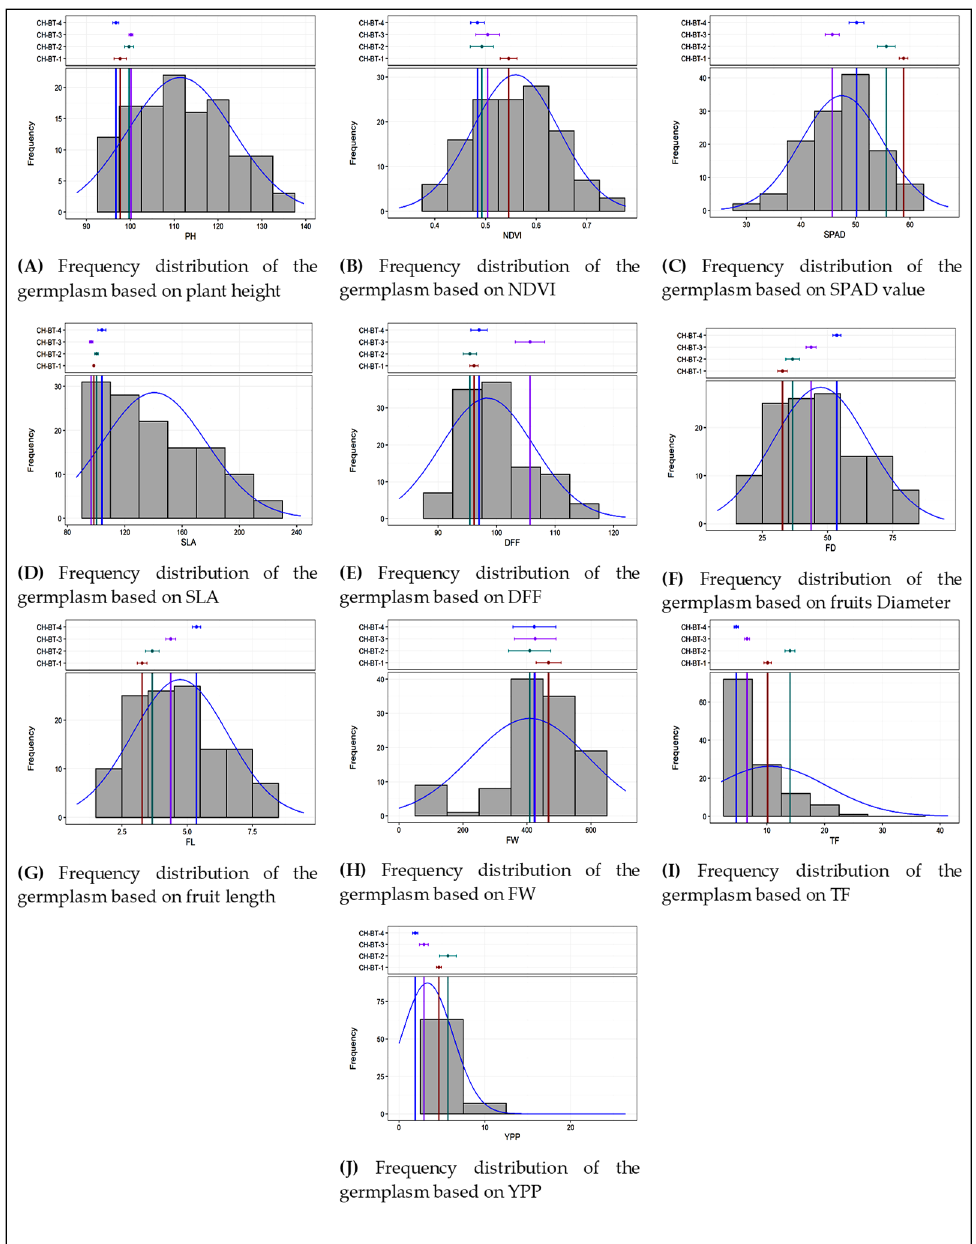
Figure 2. Frequency distribution of the germplasm based on quantitative traits: (A) Plant height, (B) NDVI, (C) SPAD value, (D) SLA, (E) DFF, (F) fruits diameter, (G) fruit length, (H) FW, (I) TF and (J) YPP of eggplant.